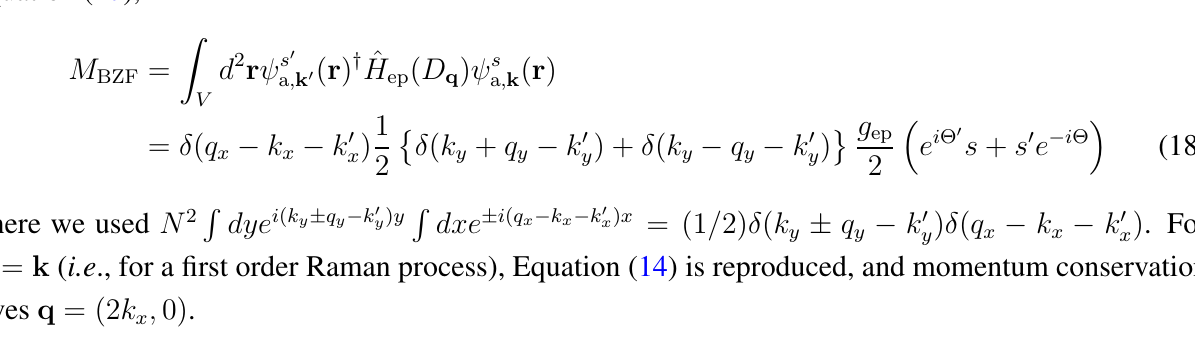
Figure 3. A process that causes the D ′ band at the zigzag edge. Phonon excitation ( q ̸ = 0 ) accompanied by a change in the electronic states, which shows that the phonon does not appear through a first-order process. Note that, in the right diagram, the color of the points changes after the phonon is